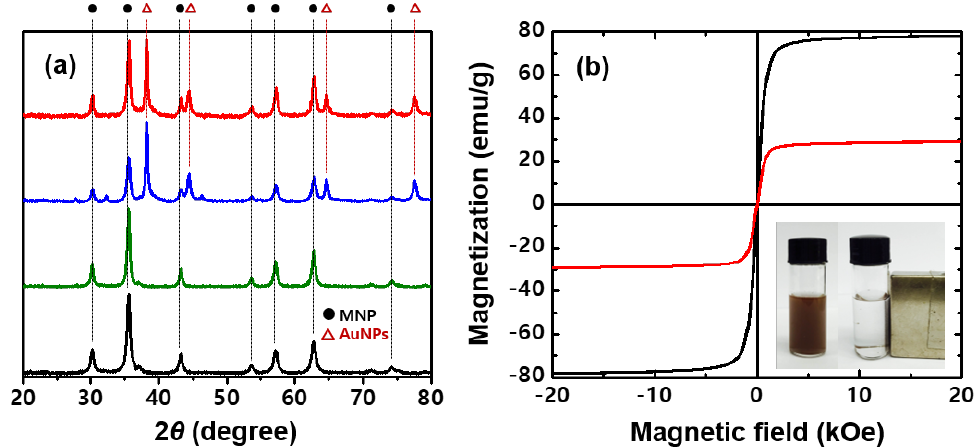
Figure 3. ( a ) XRD patterns of MNPs (black line), MNP@PD (green line), MNP@PD/Au (blue line) and MNP@PD/Au/IO (red line). ( b ) Field-dependent magnetic curves of MNPs (black line) and MNP@PD/Au/IO (red line). Inset of ( b ) is a photograph of MNP@PD/Au/IO dispersed in water ( left ) and attracted to the side of the container after applying an external magnetic field ( right ).